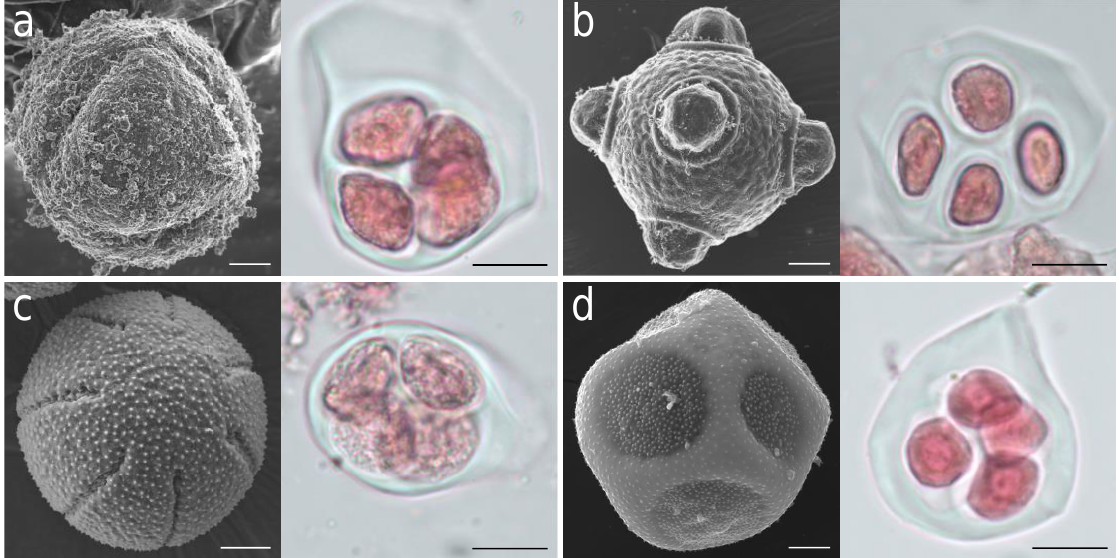
Figure 1. Images showing mature pollen ( left ) and tetrad stage pollen ( right ) for the four species studied. Images of mature pollen were taken with a scanning electron microscope and images of tetrad stage pollen with an optical microscope. Scale bars = 5 μm. ( a ) Dactylicapnos torulosa ; ( b ) Fumaria bracteosa ; ( c ) Eschscholzia californica ; ( d ) Roemeria refracta .